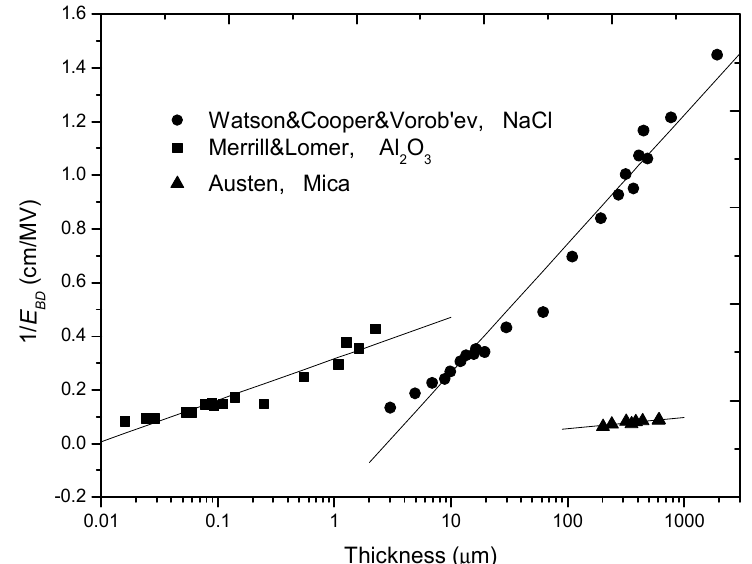
Figure 2. Experimental results supporting the reciprocal-single-logarithm relation of E BD with d